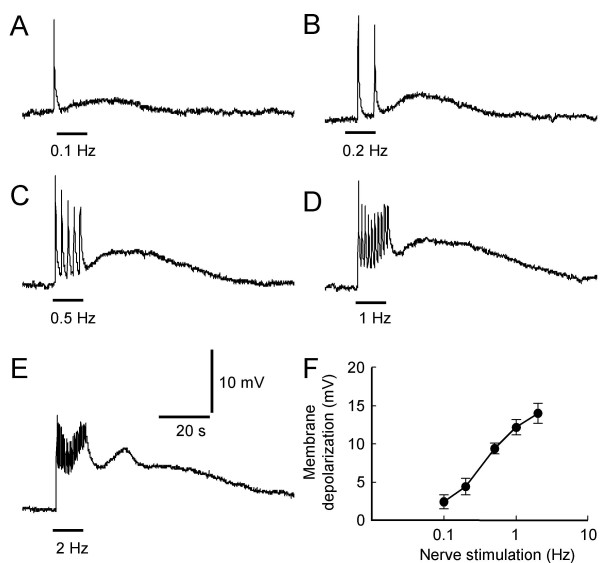
Typical biphasic membrane depolarization of canine isolated mesenteric vein. Representative intracellular recordings depicting EFS-induced (0.1 ms, 13V, 10 s, 0.1–2 Hz) biphasic membrane depolarizations, consisting of excitatory junction potentials and slow membrane depolarization (A-E). The amplitude of the slow membrane depolarization increases with the increase of stimulation frequencies (F). Mean ± SEM, n = 4–12. Scale bars apply to traces A-E.